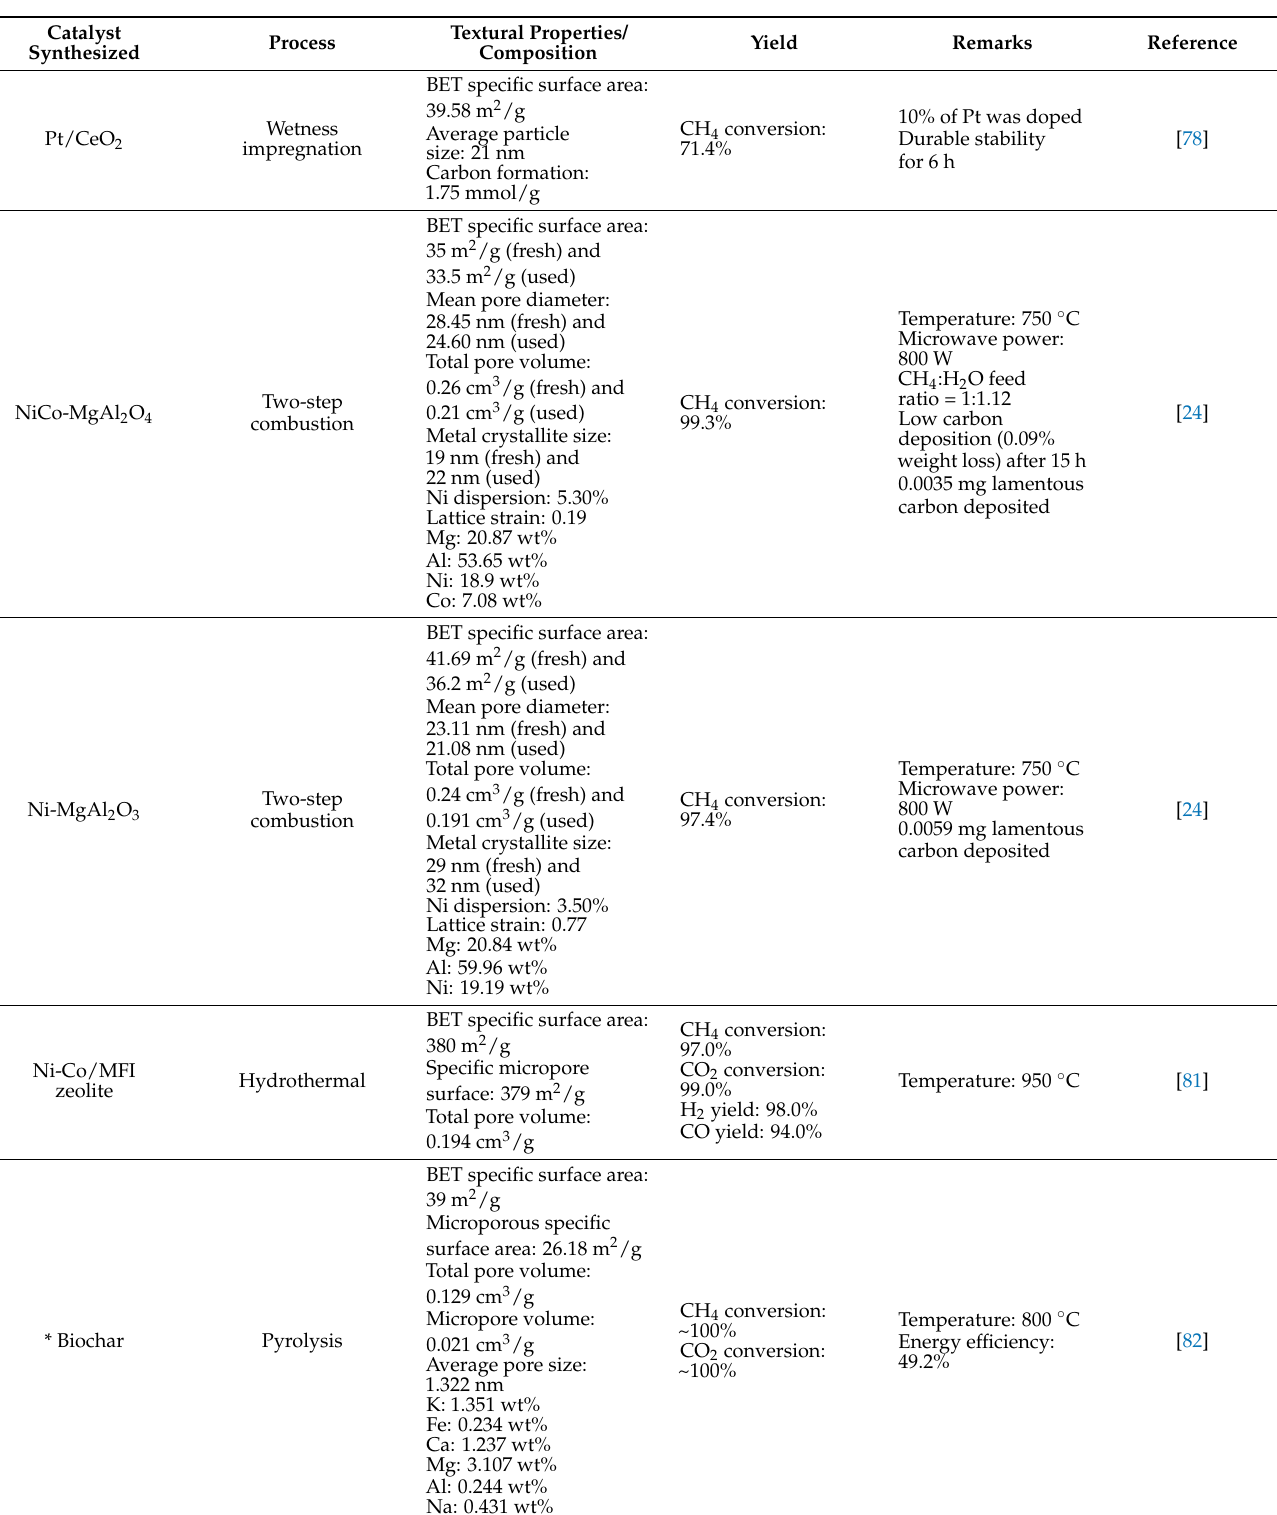
Table 6. Catalyst synthesized using microwave-assisted technologies for methane